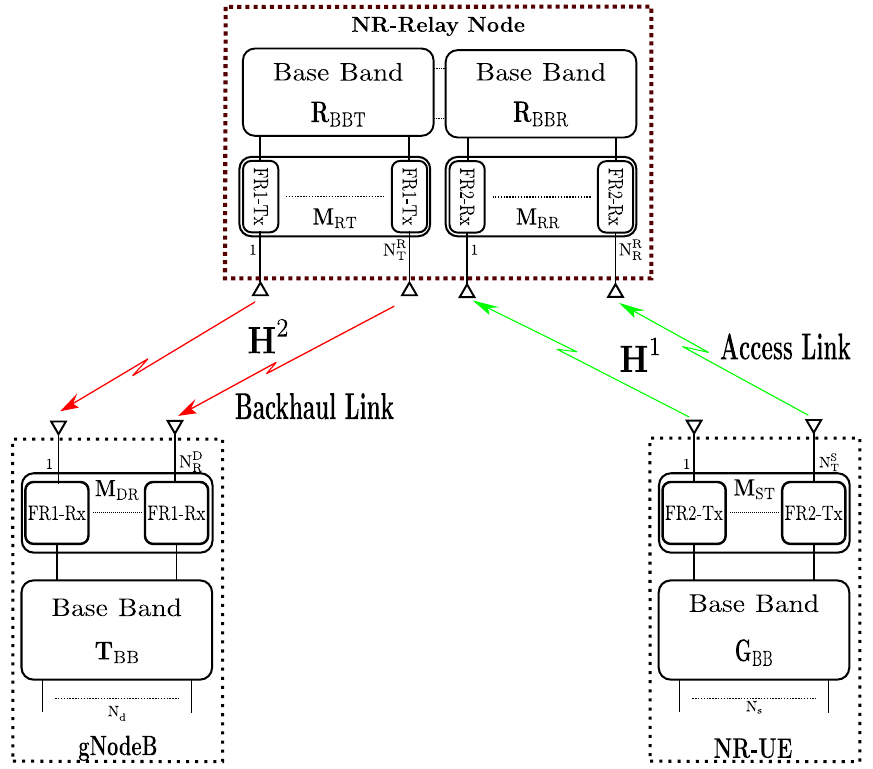
Figure 1. Uplink mmWave MIMO New Radio (NR)-relay node